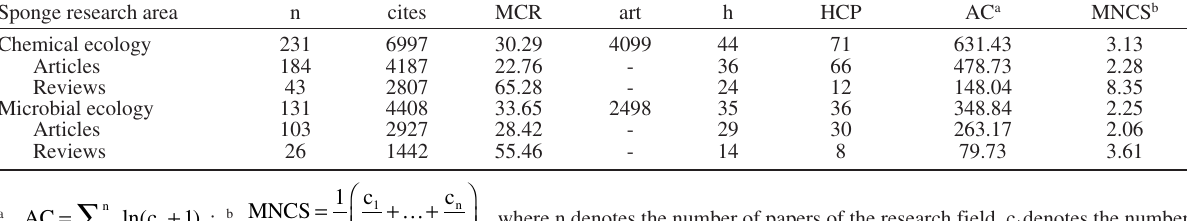
Table 1. – Total number of papers (n), total number of citations (cites), mean citation rate (MCR), total number of citing articles (art), h - index, highly cited papers indicator (HCP), aggregate of the natural logarithm of citations of each publication (AC), and mean normalized citation score indicator (MNCS) for both sponge research areas searched in the Science Citation Index Expanded database from 1900 to 2014. Research output shown by research area and within each area categorized by publication type (articles and reviews). Sponge research area